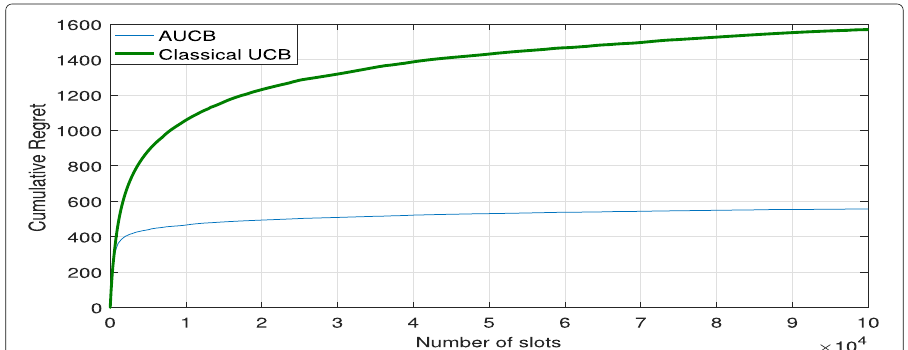
Fig. 5 Regret comparison for two approaches under the random rank policy